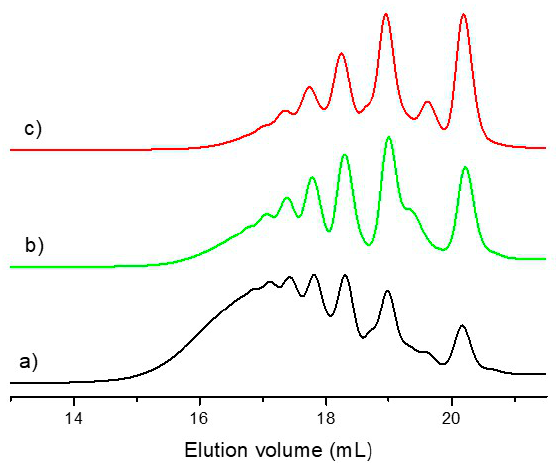
Figure 6. GPC traces of the Oligo–Salen–A, –B and –C compounds: ( a ) Oligo–Salen–A; ( b